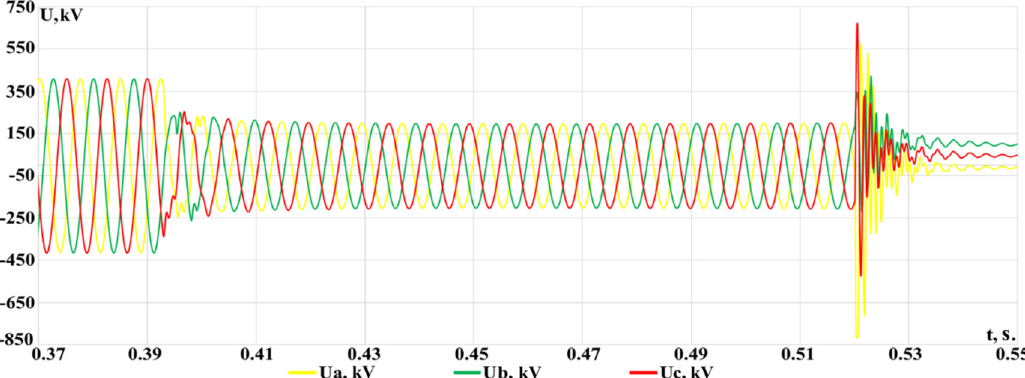
Figure 11. Voltages for a case of three ‐ phase short circuit on the B 2 buses.